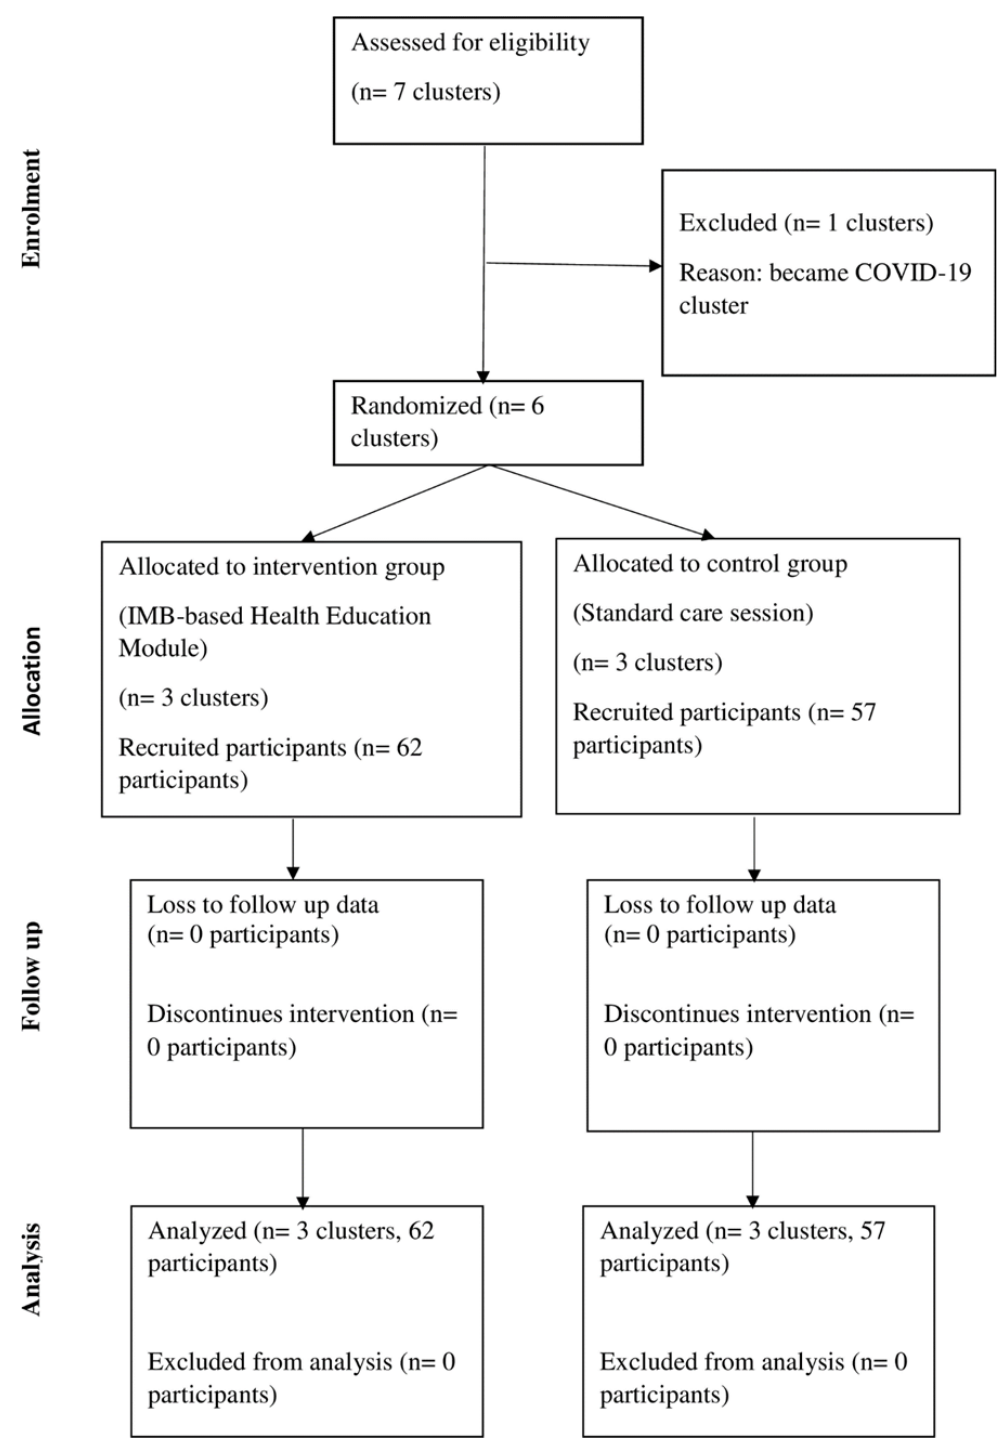
Figure 1. Flow chart of the study.